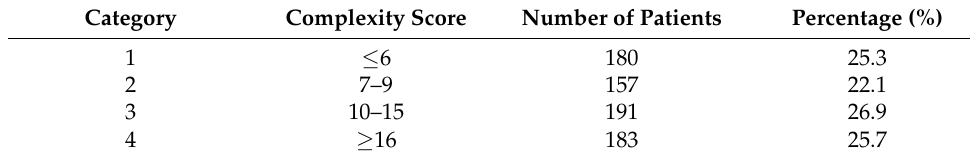
Table 2. Division of surgeries into four categories.